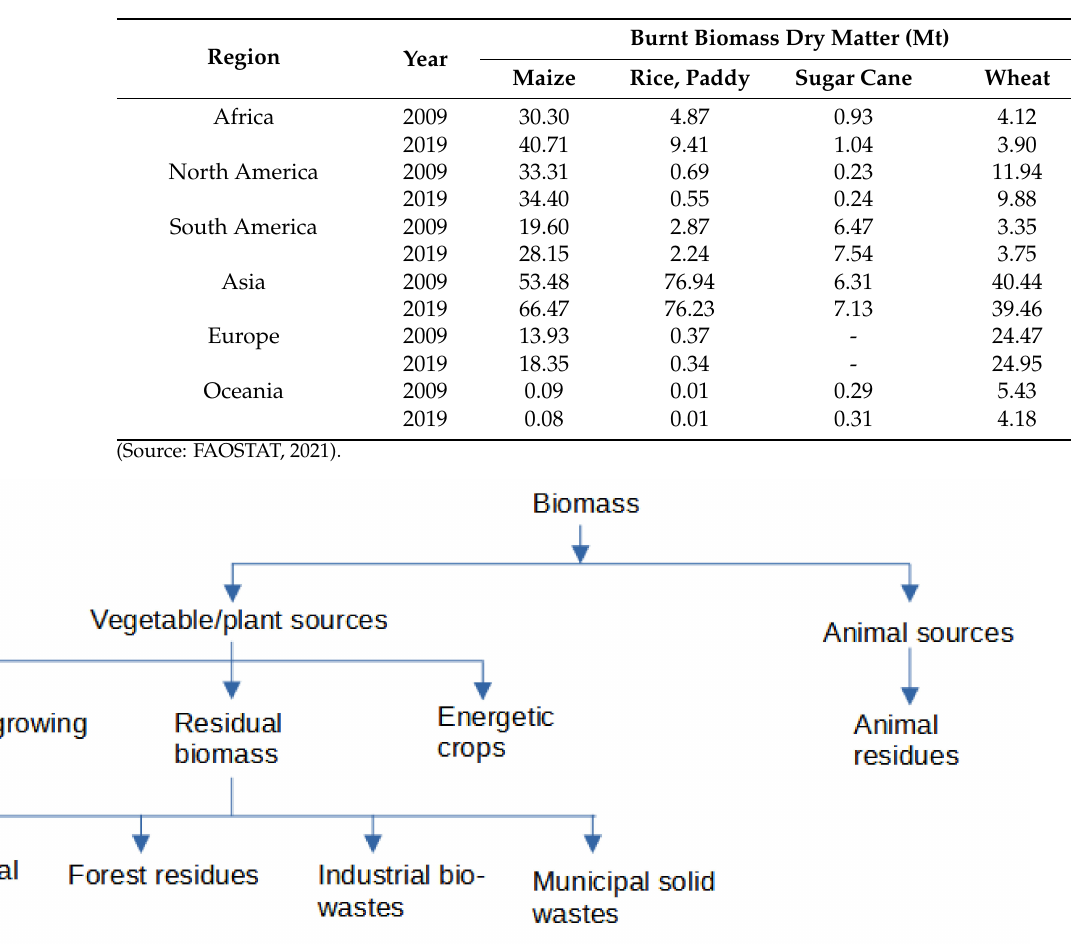
Table 1. Regional burnt biomass (dry matter, Mt).